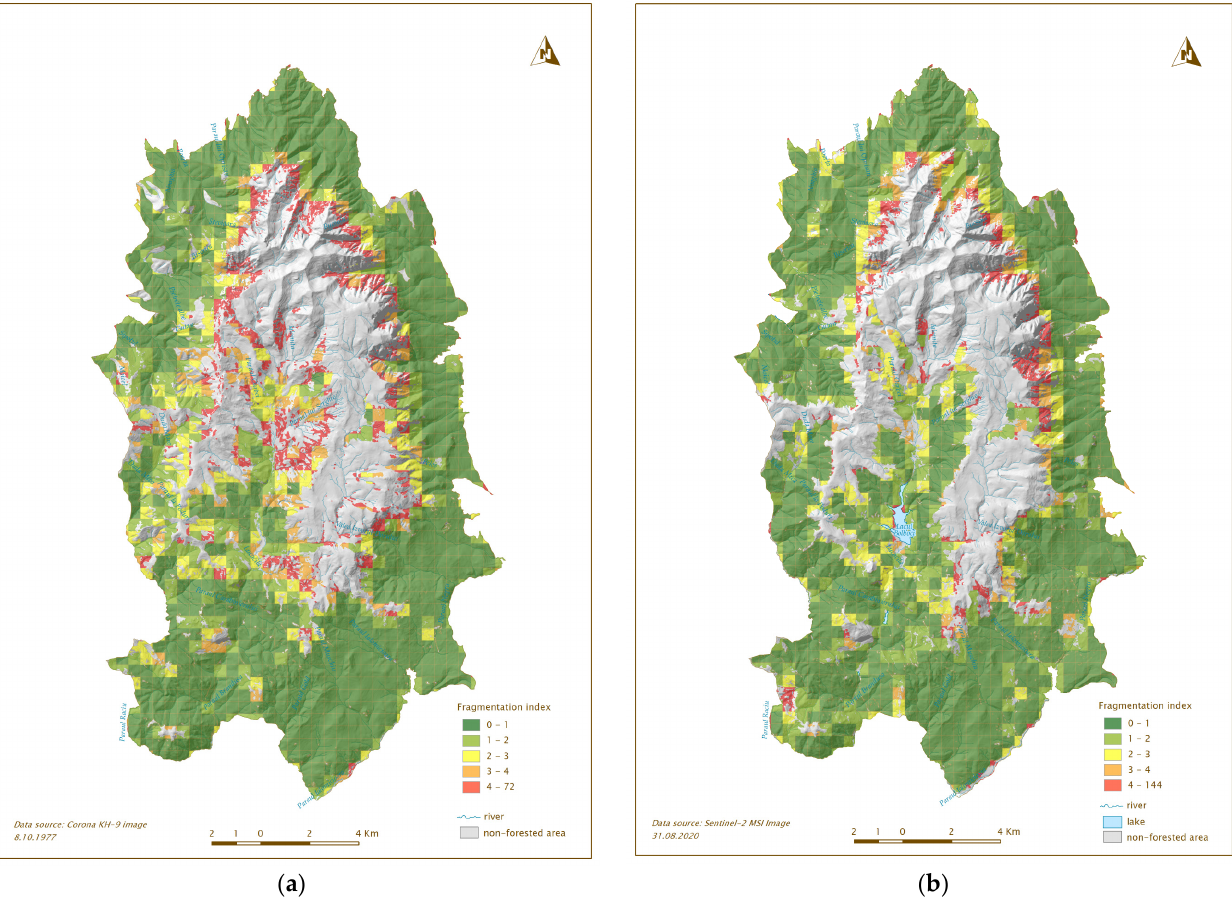
Figure 6. Bucegi Natural Park forest habitat fragmentation maps: ( a ) 1977 derived from KH-9 orthoimagery; ( b ) 2020 derived from Sentinel 2-MSI imagery.